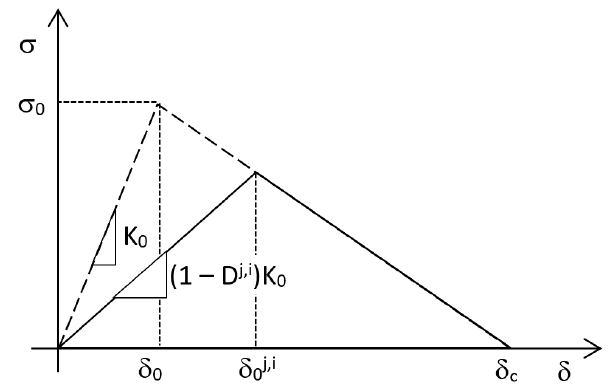
Figure 4. Cohesive law update.